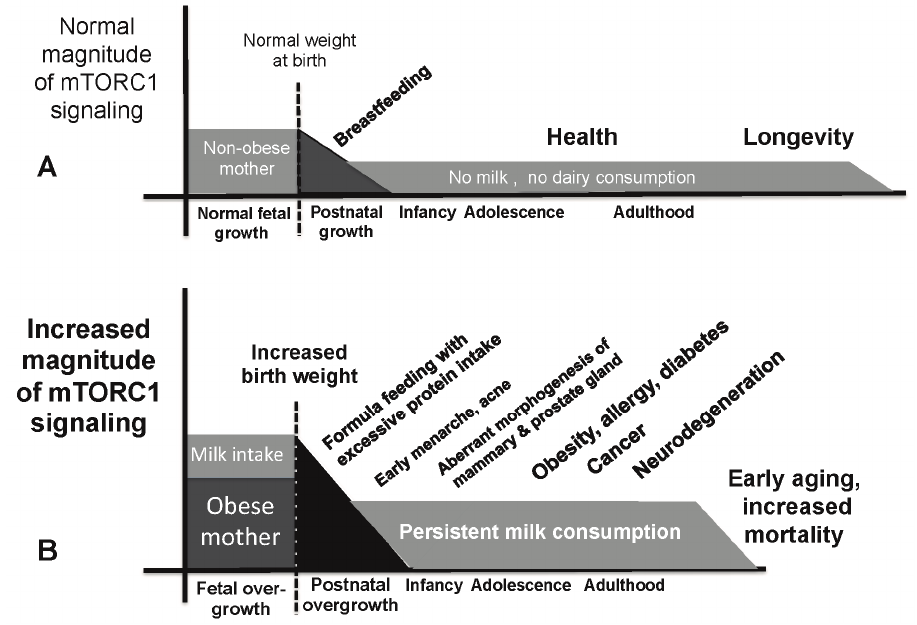
Figure 3. Synoptic model illustrates the influence of milk signaling on the magnitude of mTORC1 activation. ( A ) Physiological milk-driven mTORC1 signaling.